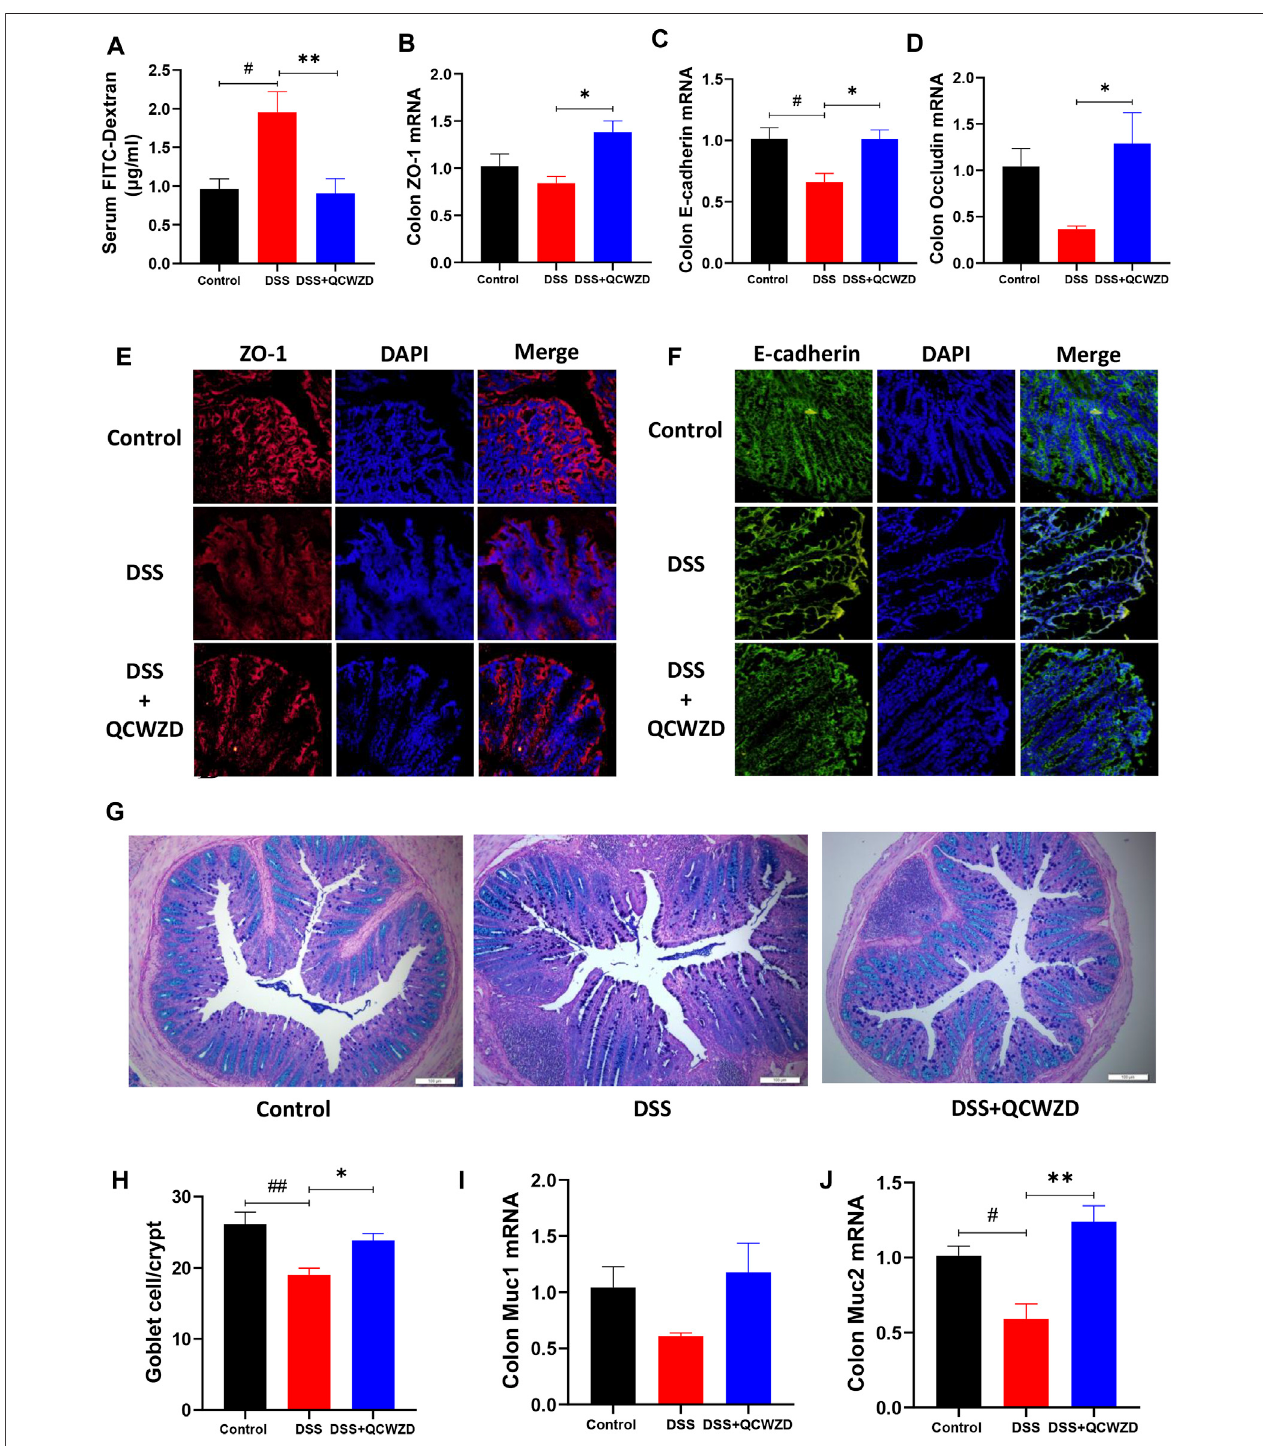
FIGURE8| QCWZDTreatmentImprovesGut Permeability through Upregulating theExpressionsofTightJunctionProteinsand NumbersofGoblet Cells. Healthy or DSS-treated mice were orally administered with 1.8 g/kg QCWZD or sterile water daily, blood samples and colon tissues were collected for further analysis. (A) IntestinalbarrierfunctionswereassessedinmicebyoralgavageofFITC-dextranonday15,followedbymeasuringtheFITC-dextransignalinbloodafter4 h (B – E) Colon tissues were collected, and the mRNA levels of ZO-1, E-cadherin and Occludin in colon were detected by RT-qPCR. (E, F) Colon tissues were collected in OCT, and frozen sections were prepared and stained by immuno fl uorescence with anti-ZO-1 or anti-E-cadherin antibodies with Cy3 or FITC-conjugated secondary antibodies.ThedistributionofZO-1and E-cadherin wereexamined.Representative fi guresfrom eachgroupareshown inpanels (E,F) . (G,H) Goblet